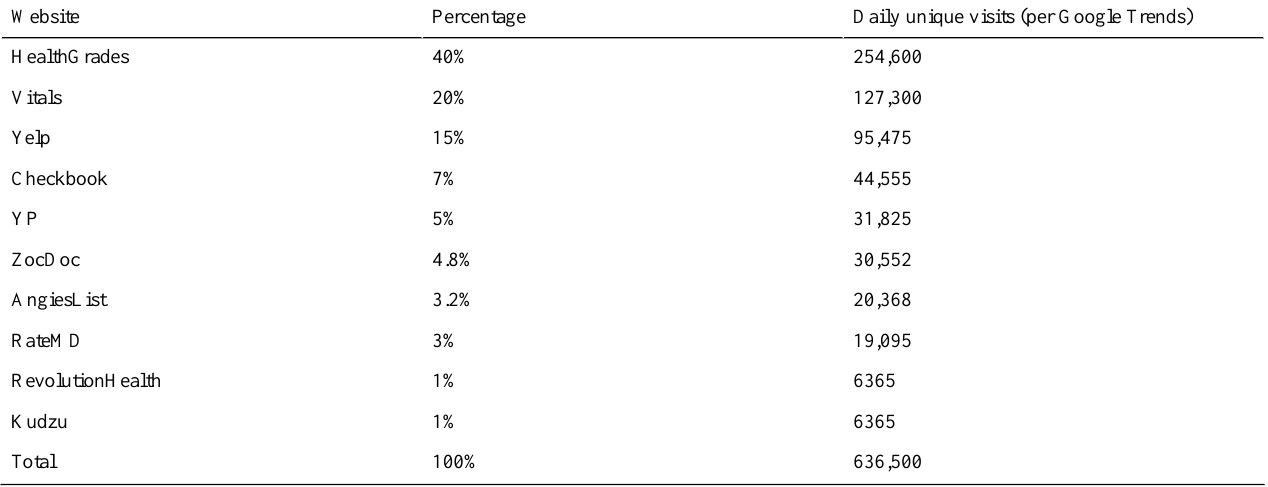
Table 2. Top 10 most frequently visited physician-rating websites as a relative measure of Web traffic as measured through Google